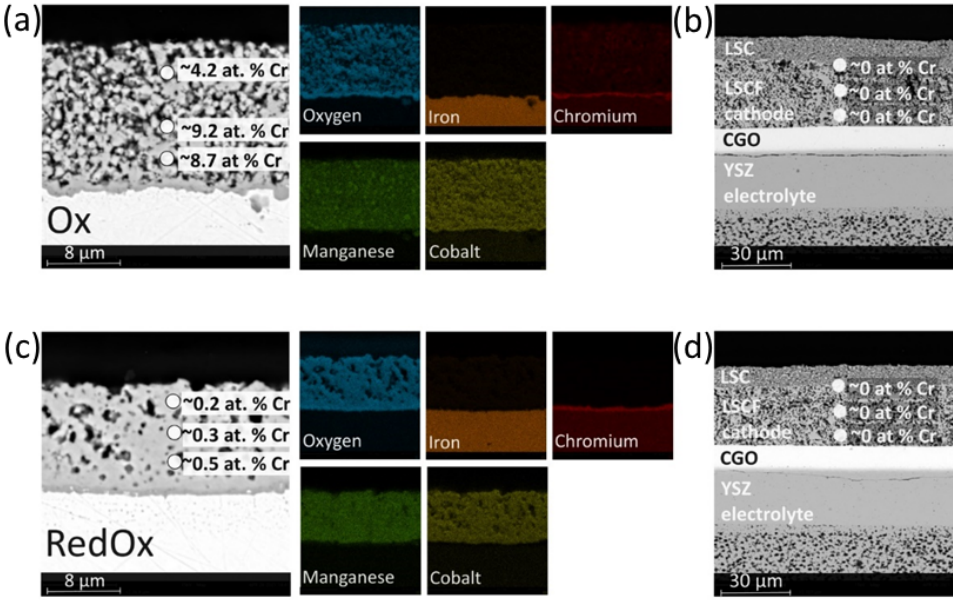
Figure 6. Post-mortem SEM analysis: ( a ) 20s_Ox sample; ( b ) fuel cell exposed to 20s_Ox sample; ( c ) 20s_RedOx sample; ( d ) fuel cell exposed to 20s_RedOx sample.